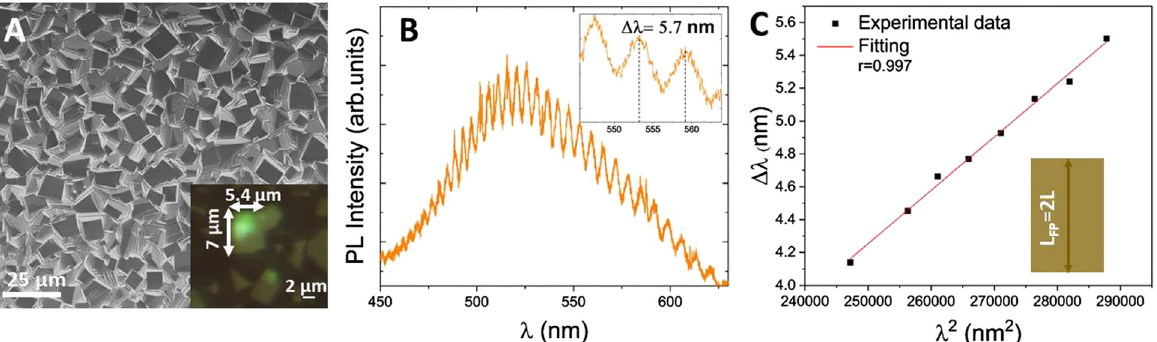
Figure 5: (A) Scanning Electron Microscope (SEM) image from NiO microcrystals. Inset in (A) shows an optical image from a detailed region withNiOmicrocrystals.(B)Photoluminescence(PL)spectrumfromthemicrocrystalintheinsetin(A)showingopticalmodulations,enlargedin theinset.(C) Δ λ versus λ 2 fromtheanalysisofthePLsignalin(B)withthecorrespondinglinear fi tting.ReprintedfromRef.[60]Copyright2021, with permission from